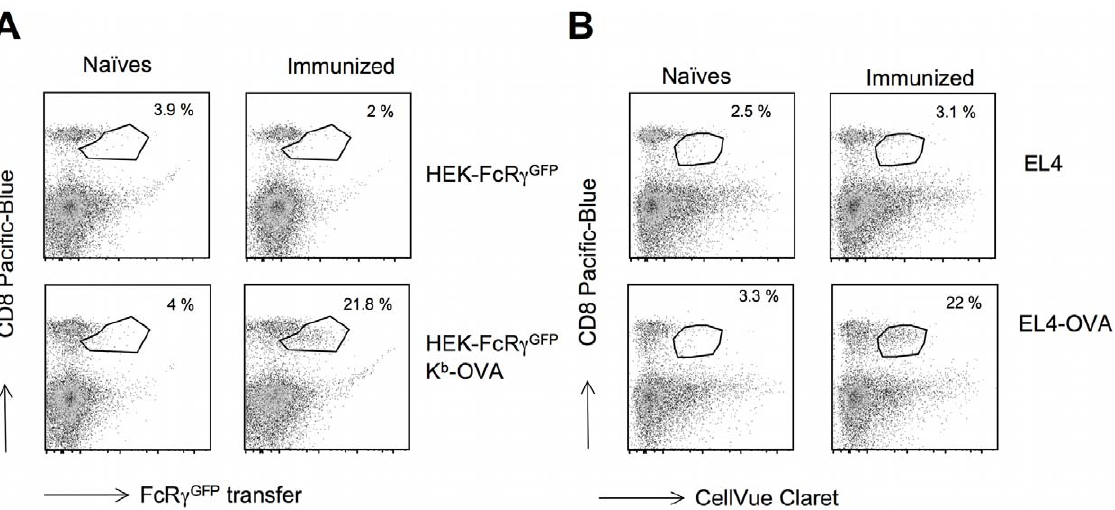
Figure 6. An efficiently transferred protein can be used in immunomonitoring assays to detect reactive T cells in TRAP assays. A) Splenocytes from B6 animals immunized (right panels) or not (left panels) with CyaA-OVA were co cultured with the B8 HEK-FcR c -GFP cells (stably expressing high levels of FcR c -GFP) transiently transfected 48 hours earlier with a vector encoding covalent H-2K b - b 2m-OVA (bottom panels) or left untransfected (top panels). At the end of the co-culture, cells were analyzed by flow cytometry and GFP fluorescence is plotted as a function of CD8 staining. Numbers represent the percentage of CD8 + cells expressing GFP (present in the gate drawn in the graph). B) As in A except that splenocytes were incubated with EL4 cells labelled with the fluorescent lipophilic probe CellVue Claret loaded (bottom panels) or not (top panels) with the OVA peptide. The Fluorescence signal from CellVue Claret was analyzed as a function of CD8 staining. Numbers represent the percentage of CD8 + cells expressing CellVue Claret fluorescence (falling within the gate drawn in the graph).